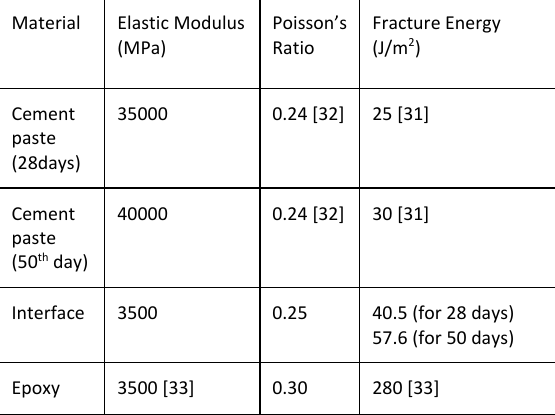
Table 1. Material properties of cement paste, interface, and epoxy